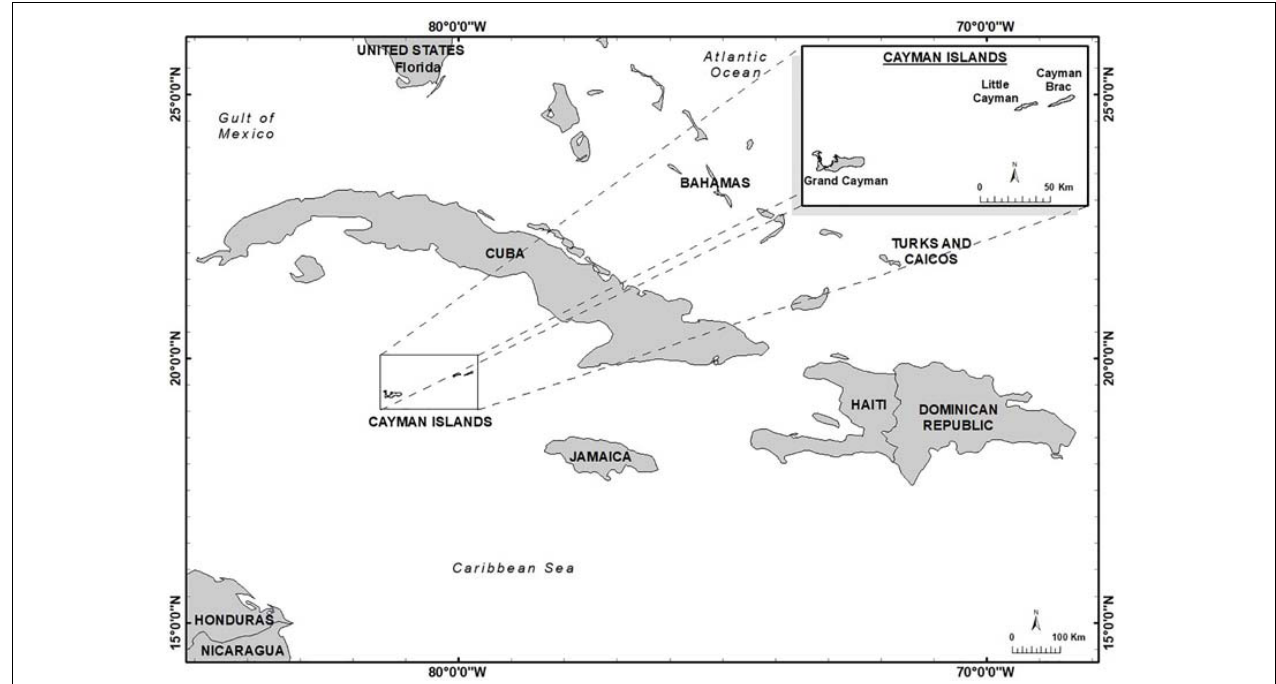
FIGURE 1 | Location of the Cayman Islands in the Caribbean